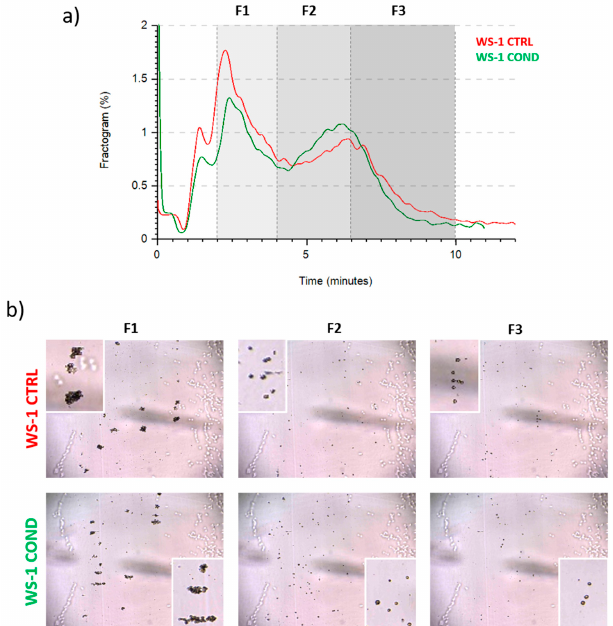
Figure 2. ( a ) WS-1 CTRL and WS-1 COND fractogram. ( b ) Different frames obtained from post-processing analysis of WS-1 CTRL and WS-1 COND. Cellular aggregates are particularly evident at 2 min from the beginning of measurement. In the boxes, the images show the cellular aggregates and the single cells.